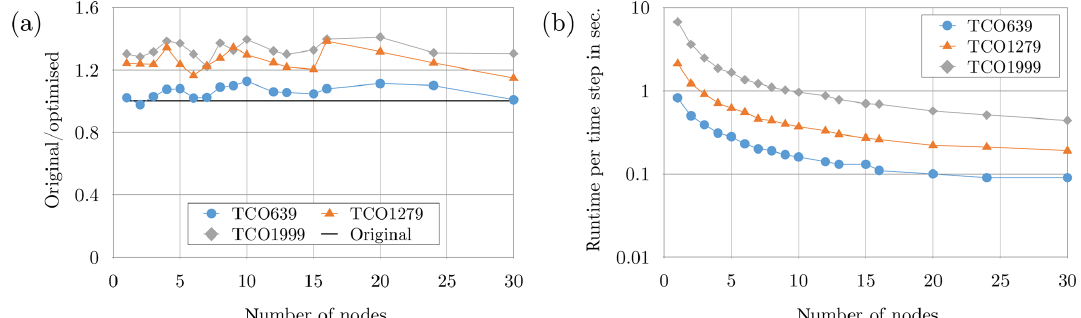
Figure 9. Performance measurements on up to 30 Intel ® Xeon Skylake 6148 nodes. Panel (a) shows the speed-up at 18km resolution ( N T = 639) with regards to different optimisations of the communication preparation phase. Panel (b) shows the computational performance for three different resolutions of 18km ( N T = 639), 9km ( N T = 1279), and 5km ( N T = 1999) representative of current and future operational requirements. Note the use of log scale. The points were connected with lines for the purpose of improving readability. All of these results have been obtained through measurements on the ATOS BullSequana × 400 supercomputer of ATOS internal HPC resources.